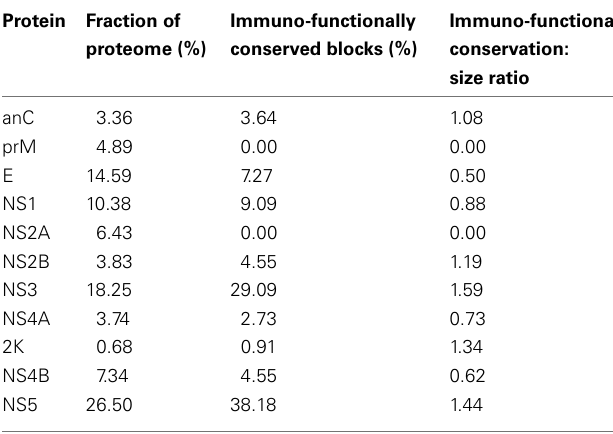
Table 5 |The ratio of conservation to size of each DENV protein is